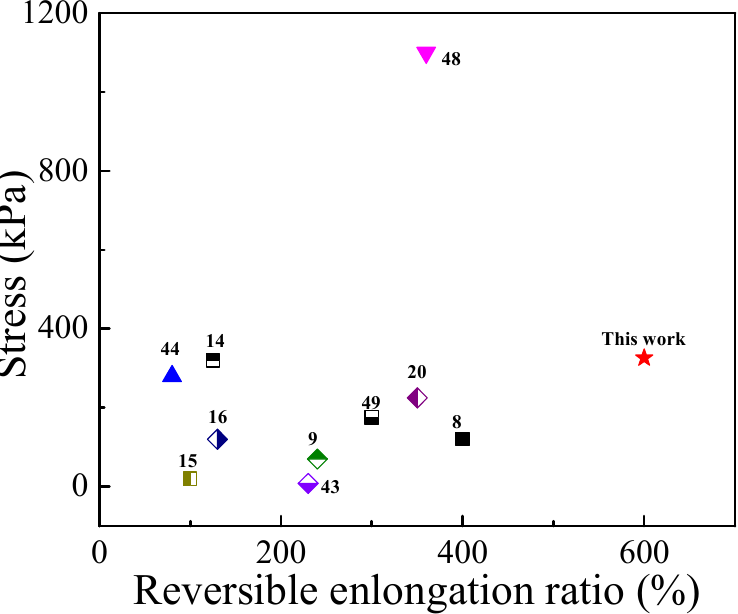
Figure 7. The tensile performance of PTAA-25 in this work and PVA-based hydrogels in others’